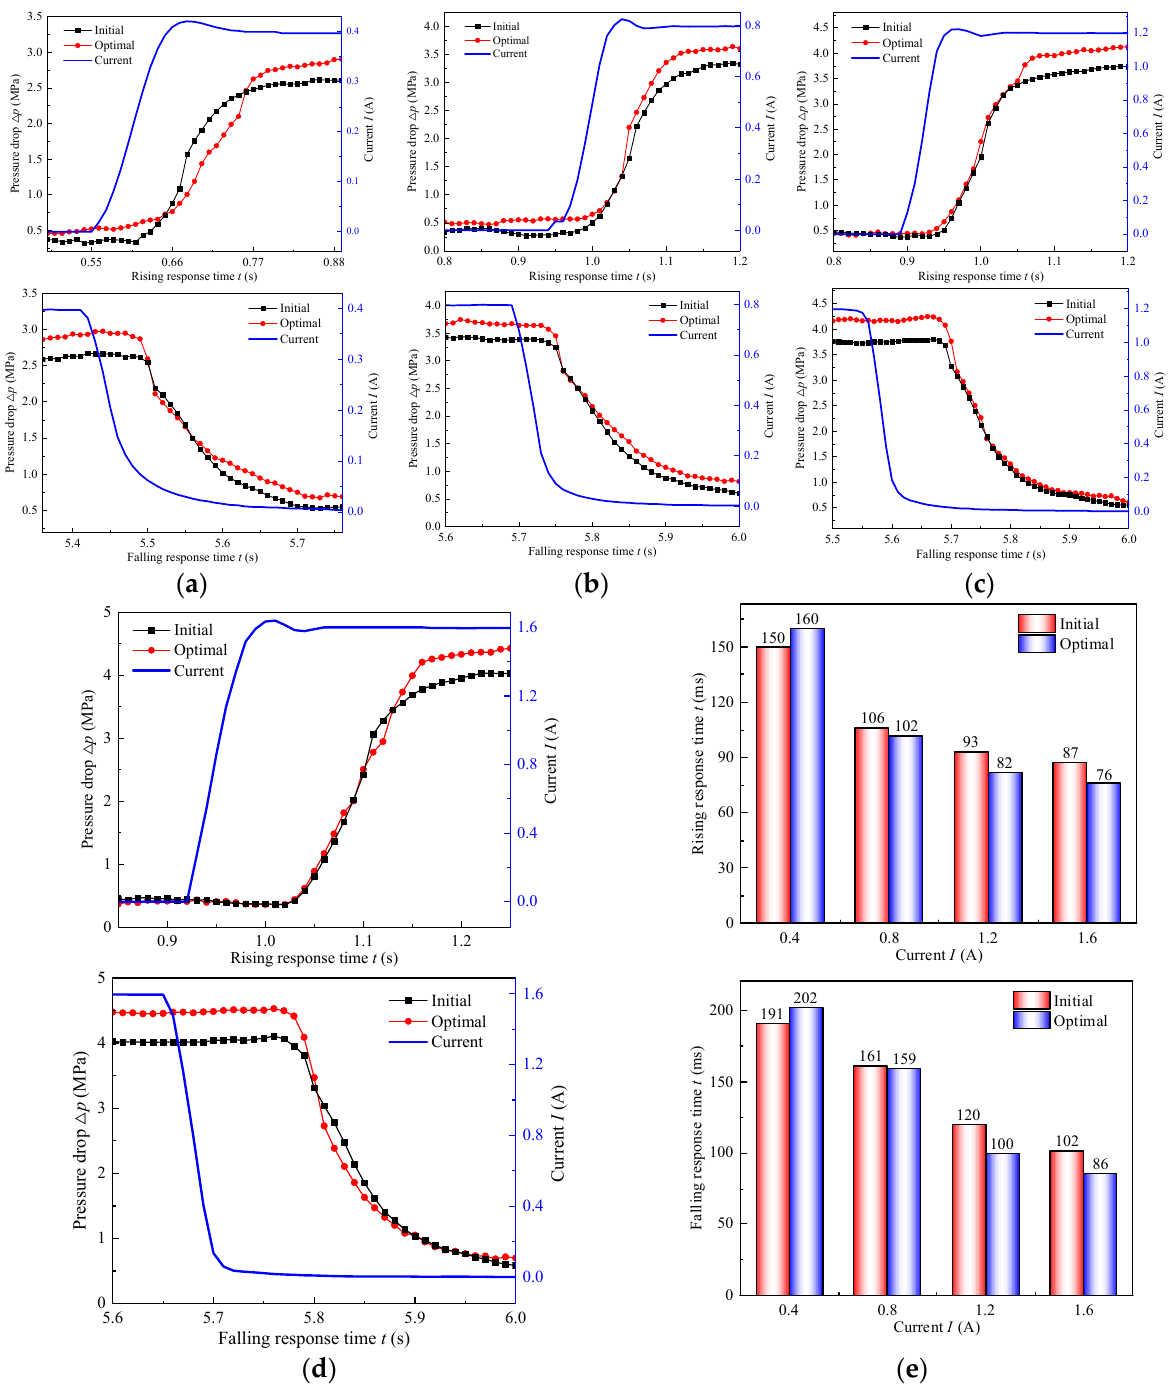
Figure 20. Dynamic response times in rise and fall phases of the initial and optimal MR valve: ( a ) 0.4 A, ( b ) 0.8 A, ( c ) 1.2 A, ( d ) 1.6 A, ( e ) response time. Figure 21a plots the experimental results that the pressure drop of the optimal MR valve under each current is decidedly larger than that before optimization, and the gap between them increases with the augment of current. When the applied current is 1.6 A, the pressure drop of the optimal MR valve is 4.46 MPa which is 10.67% more than that of the initial MR valve with a pressure drop of 4.03 MPa. Similarly, Figure 21b represents the power consumption of the initial and optimal MR valve increases exponentially with the lift of pressure drop. Under the applied current of 1.6 A, the optimal MR valve has